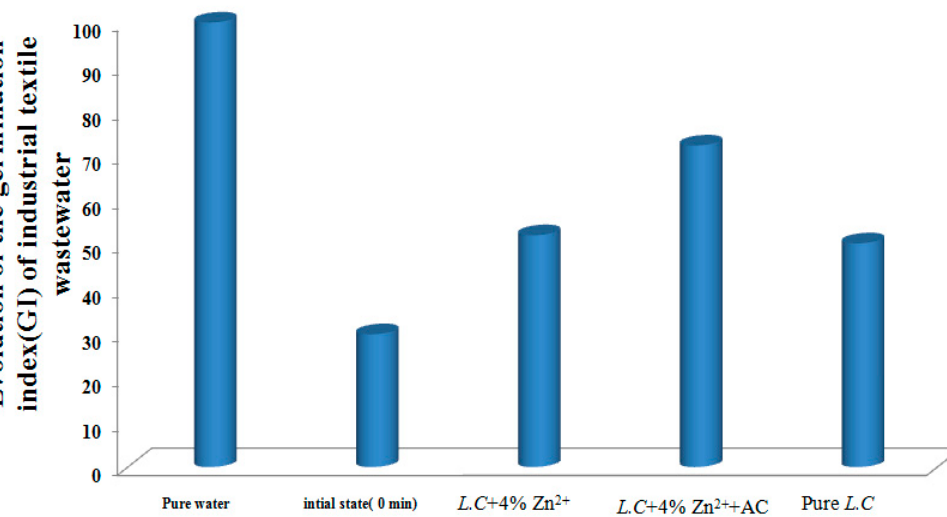
Figure 6. Evolution of the % GI after coupling biosorption with AC using pure L.C and hybrid material L.C + 4% Zn 2+ synthesized in presence and absence of AC.